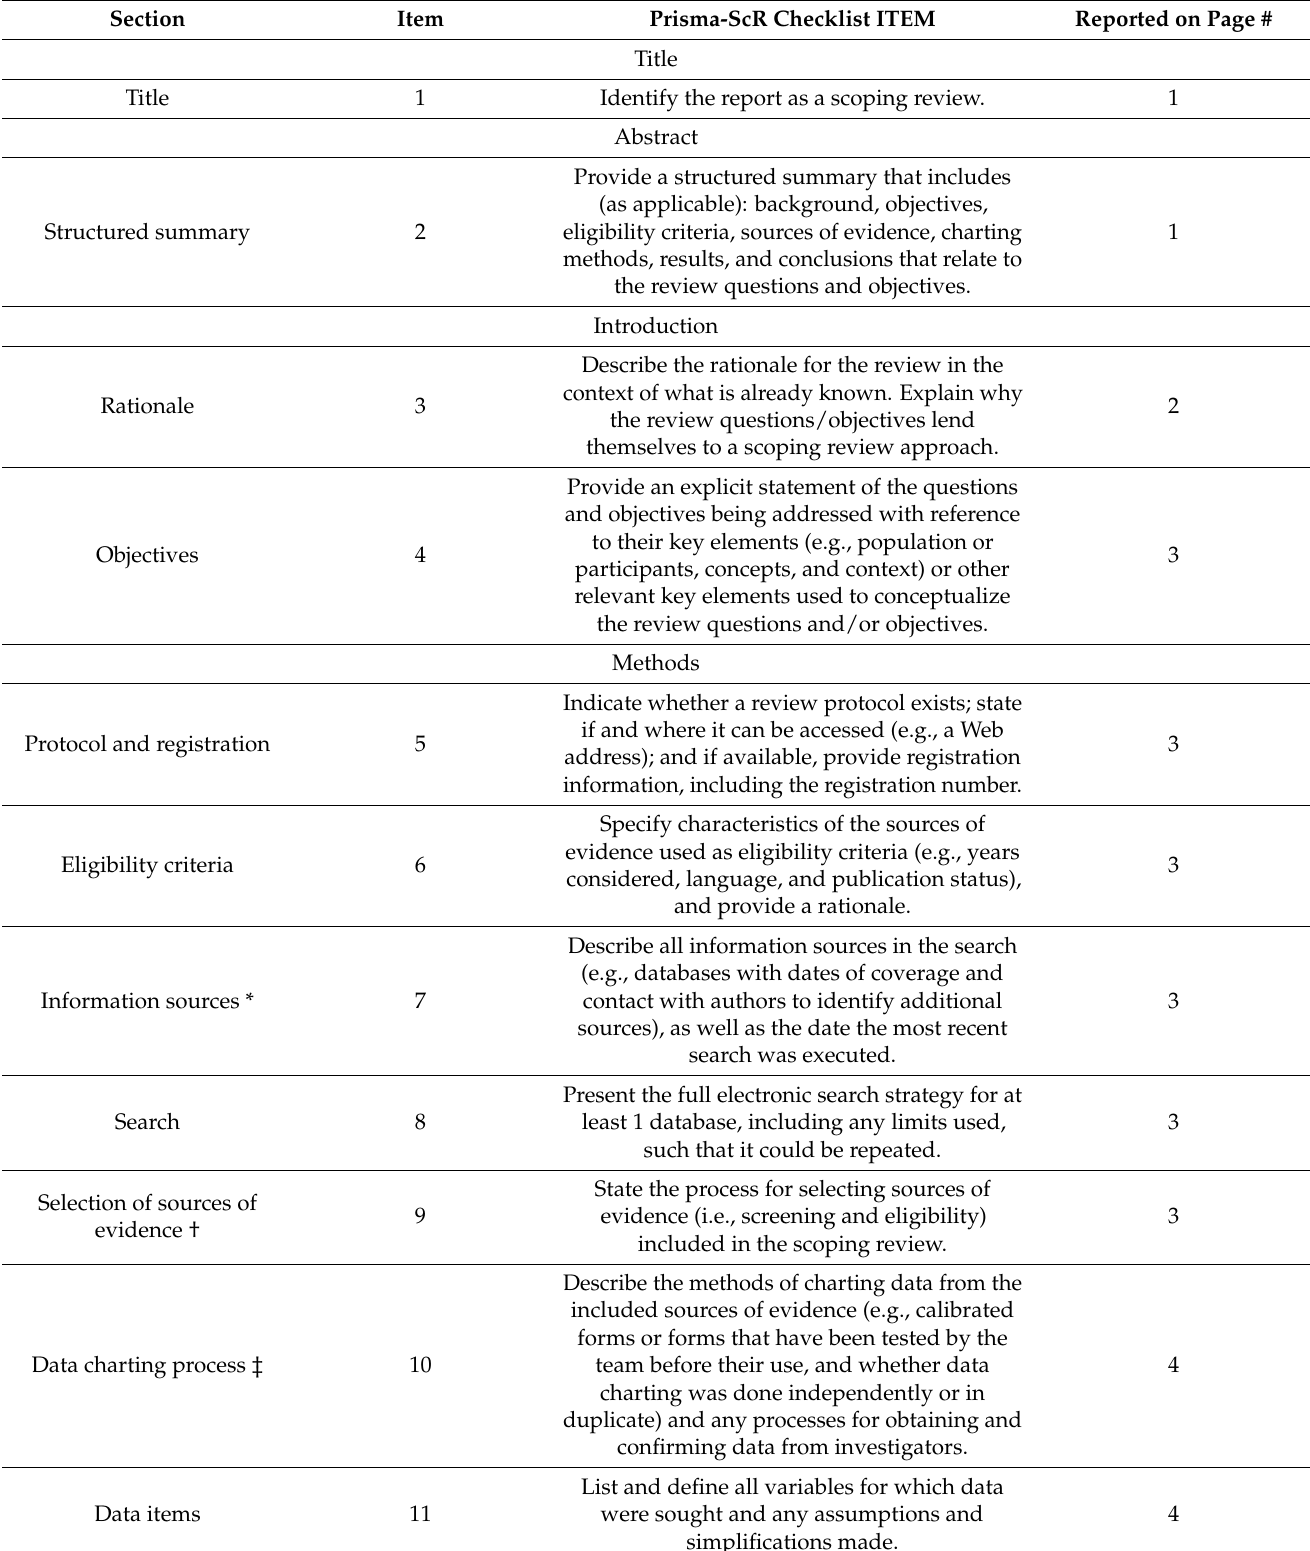
Table A1. Preferred Reporting Items for Systematic Reviews and Meta-Analyses extension for Scoping Reviews (PRISMA-ScR)